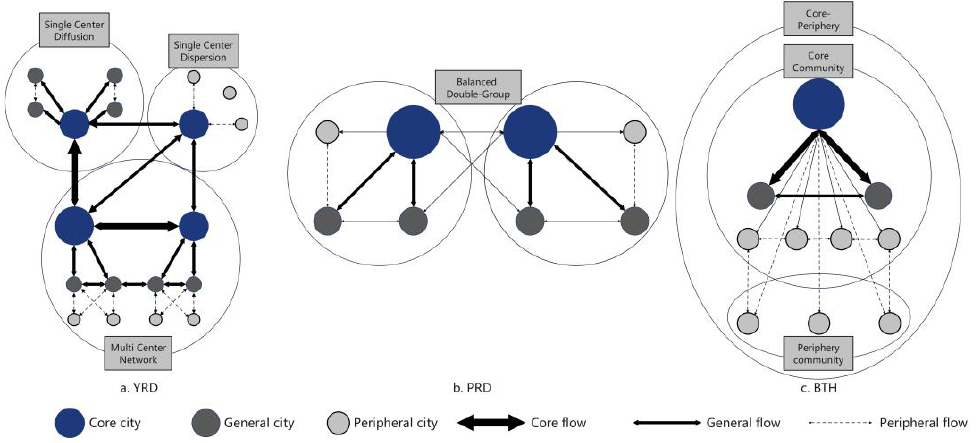
Figure 7. Spatial organizational patterns of three major urban